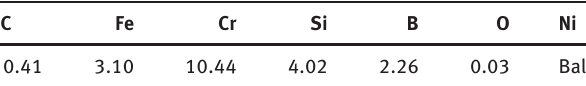
Table 2: Chemical composition (wt.%) of hardfaced powder (Colmonoy-5).